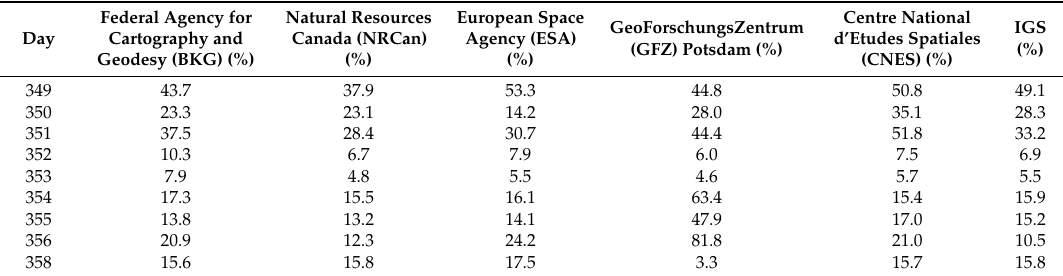
Table 1. Loss rate of real-time clock products in each analysis center.